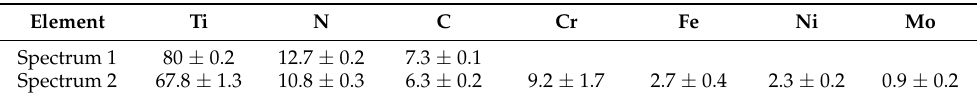
Figure 3. Scanning electron micrograph of the morphology of a titanium carbonitride precipitate in the grain boundary and interior.